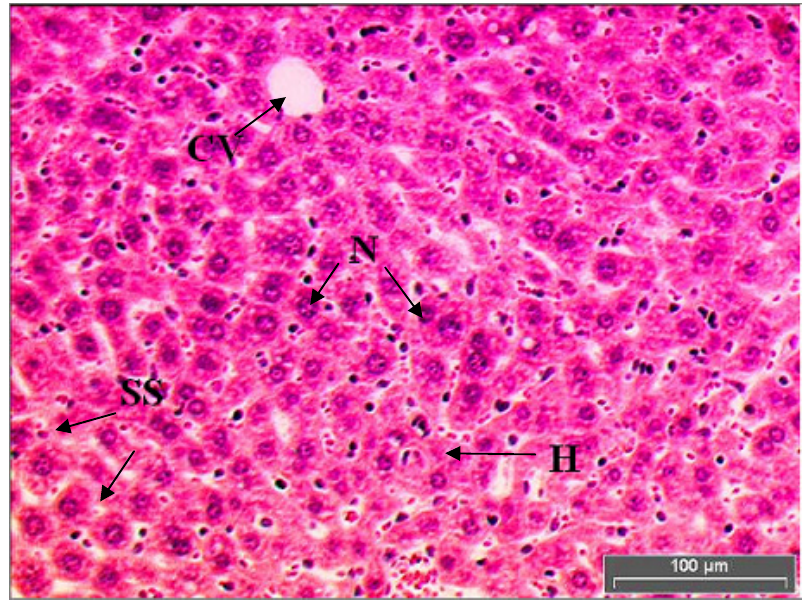
Figure 2. Light microphotographs of haematoxylin and eosin stained sections of the formalin fixed liver cell of normal mice. Liver cells of Group 1 mice (normal) have hepatic cells with well-preserved cytoplasm, prominent nucleus and nucleolus. (H, hepatocytes; N, nucleus; SS, sinusoid; CV, central